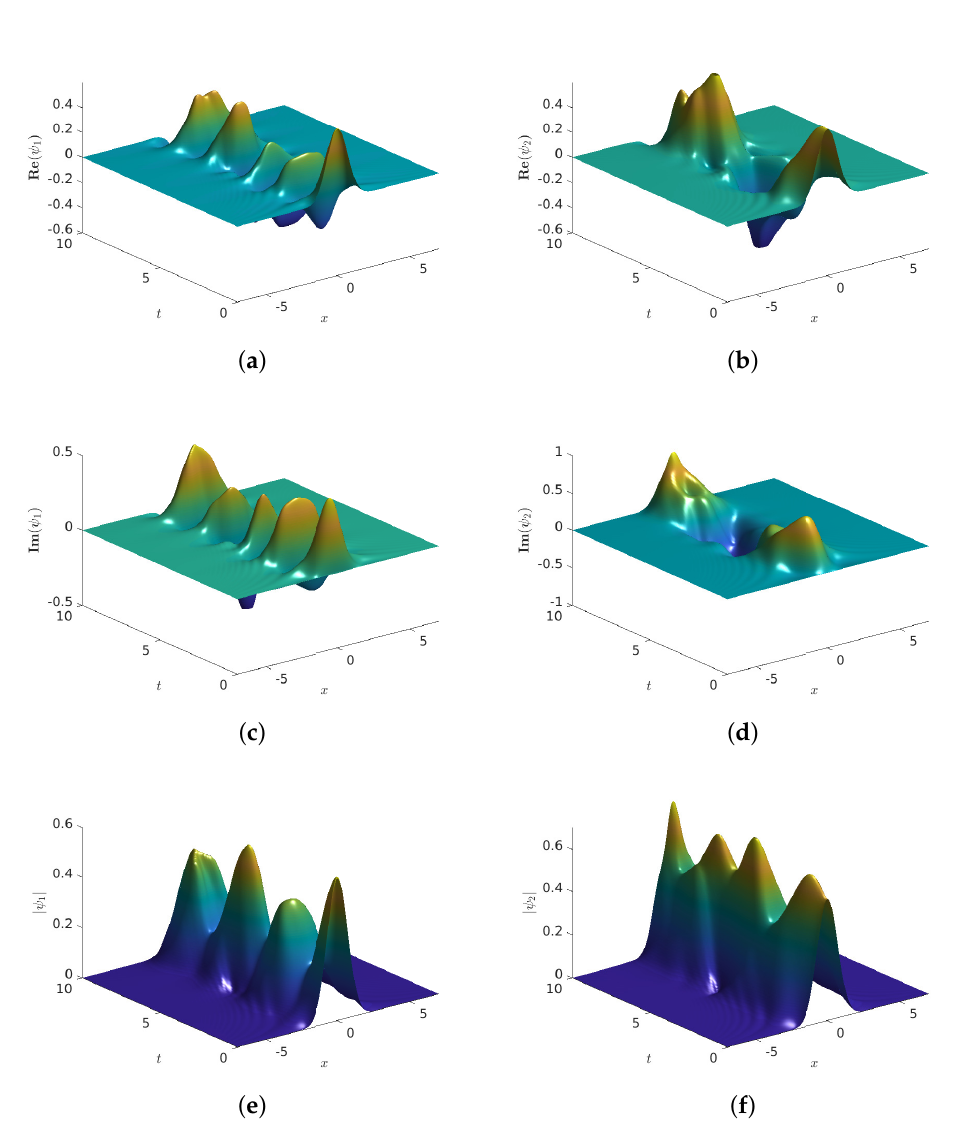
Figure 3. Numerical approximations to the solutions of Equation (4) versus x and t , using the constants of Table 1. The graphs were obtained using the finite-difference method of Equation (16) with T = 10, α 1 = α 2 = 1, τ = 0.01 and h − 1 = 0.1. We also let V ( x ) = 1 1 √ exp ( − x 2 ) for each x ∈ Ω . The graphs provide ( a ) Re ( Ψ 1 ) , ( b ) Re ( Ψ 2 ) , ( c ) Im ( Ψ 1 ) , ( d ) Im ( Ψ 2 ) , ( e ) π | Ψ | , and ( f ) | Ψ | 2 1